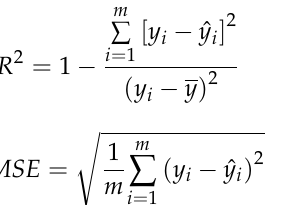
A site-based 10-fold cross-validation method was utilized to evaluate the predictive performance of different models. The monitoring sites were randomly partitioned into 10 relatively equal-sized subsets and represented with subset numbers (i.e., 1, . . . , 10). Each subset served exactly once as the source of validation samples. The models were trained using the monitoring data from the remaining nine subsets and then used to make predictions for the validation samples. The process was repeated 10 times so that each mea- sured concentration had a paired predicted concentration. The predictive performance was measured with the coefficient of determination ( R 2 ) and root mean square error ( RMSE ).